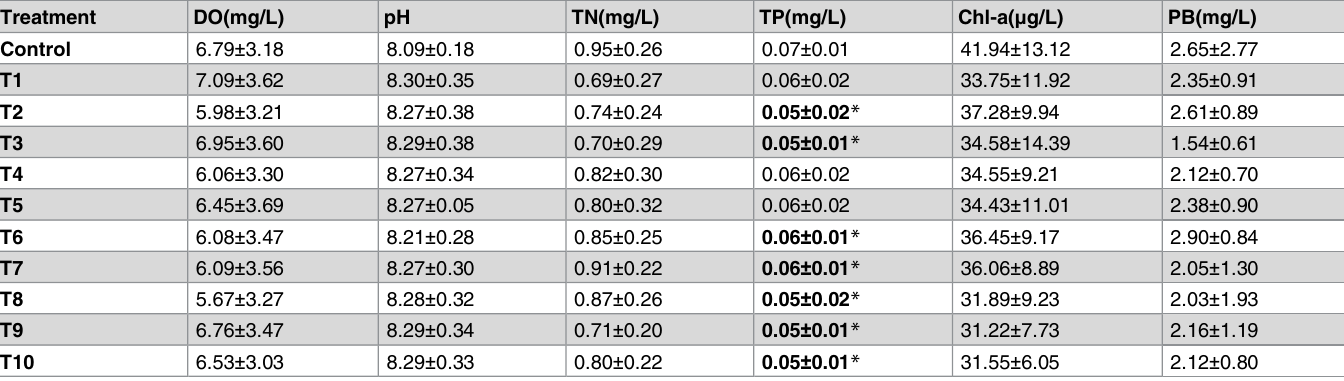
Table 2. Mean values of environmental parameters for each treatment (Mean ± std.). Treatment